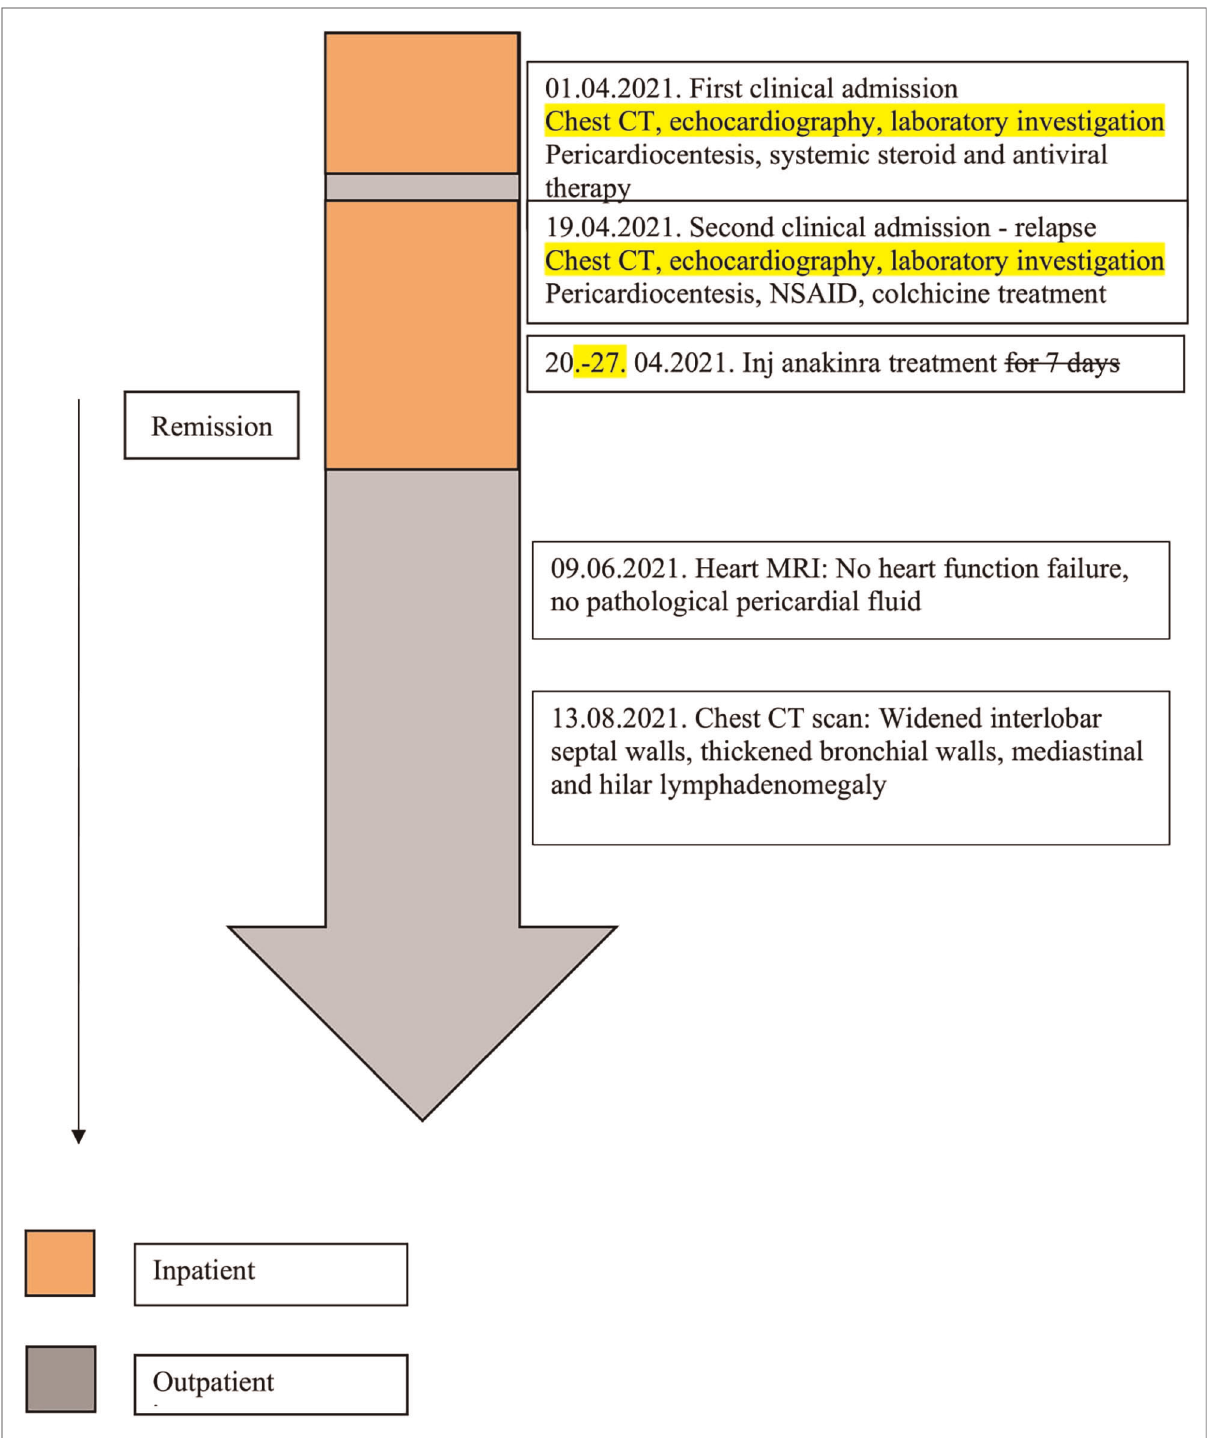
FIGURE 3 Timeline of